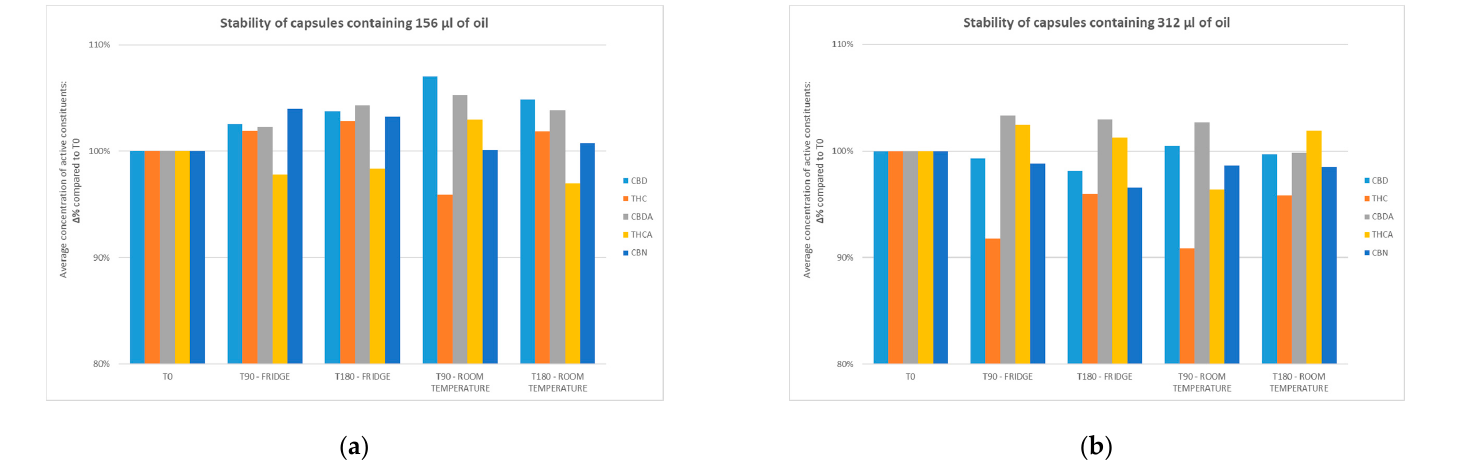
Figure 2. Capsules stability: average concentration of active constituents compared to T0. ( a ) Stability of capsules containing 156 µL of oil in fridge and at room temperature; ( b ) Stability of capsules containing 312 µL of oil in fridge and at room temperature. T0: initial conditions; T 90: 90 days; T 180: 180 days. Standard deviation for oils has been detailed in Table 3.